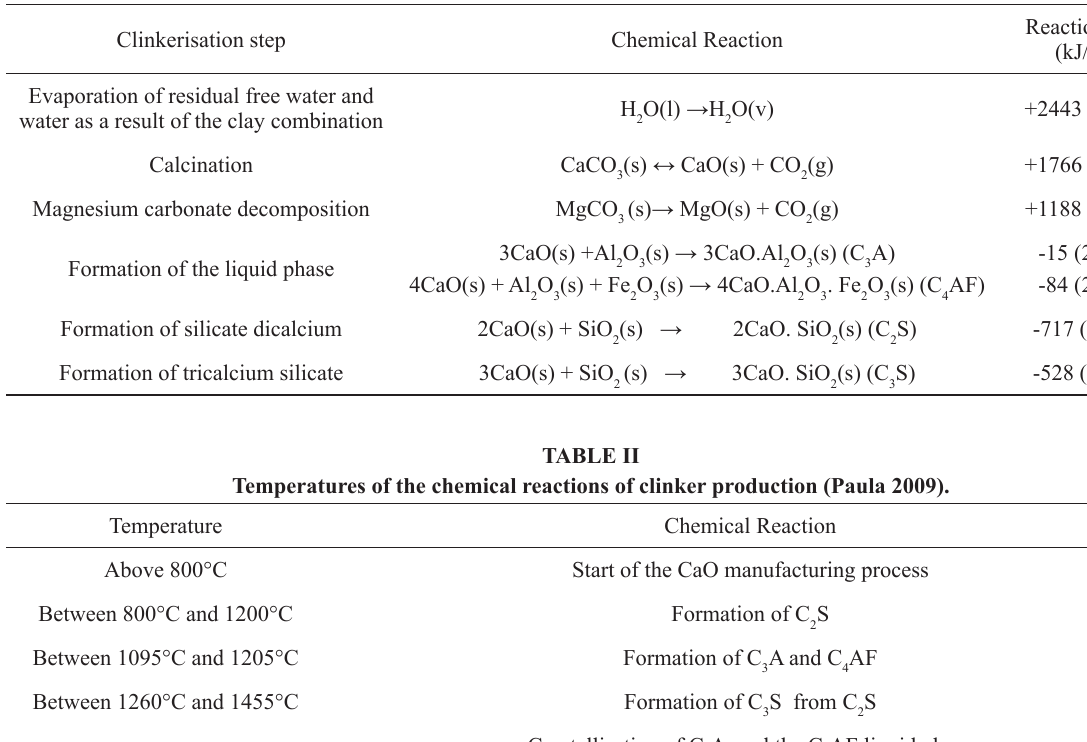
Chemical reactions of the clinker production process (Paula 2009, Smith 2007).